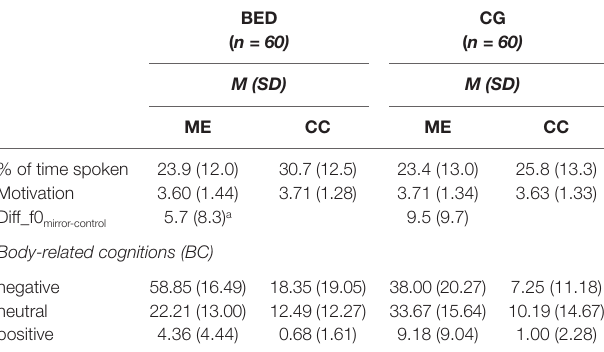
TABlE 2 | Means (M) and standard deviations (SD) for dependent variables for women with binge eating disorder (BED) and women with overweight and obesity